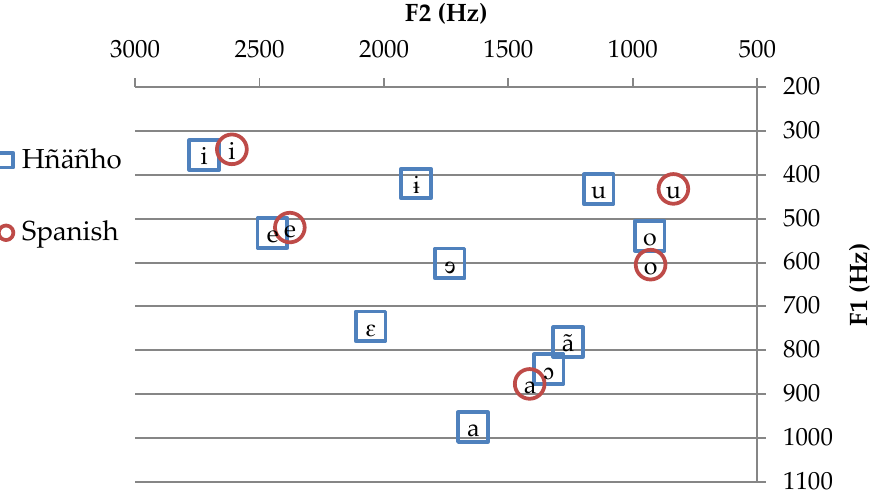
Figure 1. The vowel system of Hñäñho (vowel tags in blue squares) and Mexican Spanish (vowel tags in red circles) as produced by three female, native Hñäñho speakers highly proficient in Spanish. Vowel tags represent the mean of all produced vowel tokens (also see Mulík et al. 2021b). According to Hekking et al. (2010, 2014), Hñäñho vowels /a e i o u/ are pronounced similarly to the Spanish vowels/ a e i o u /, and the remaining Hñäñho vowels/ ɨ ɛ ɘ ɔ ã /are